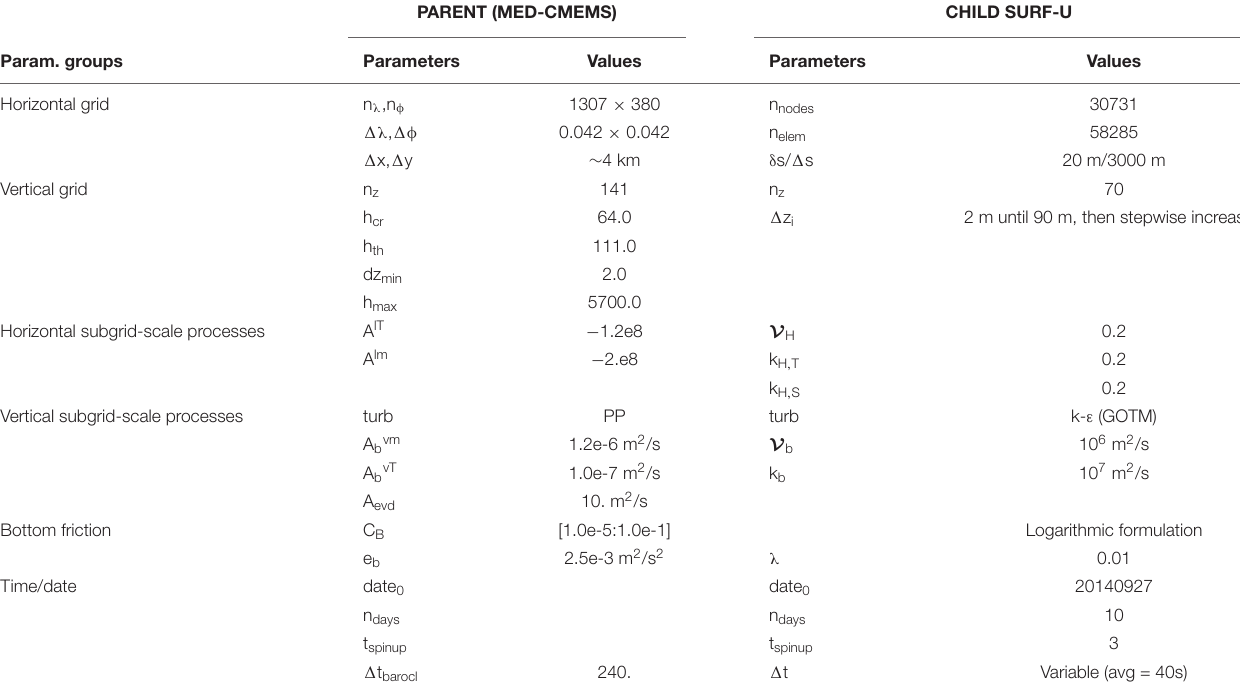
TABLE A2 | Model parameters characterizing the Gulf of Taranto study case.